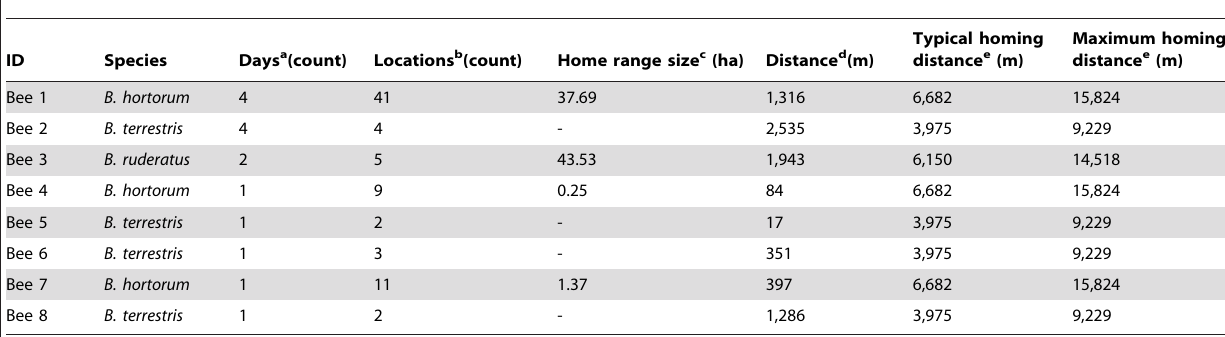
Table 1. Results from tracking individual bumblebees fitted with miniaturized radio